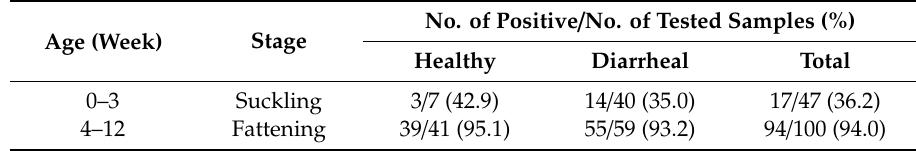
Table 2. Prevalence of porcine sapelovirus (PSV) infection of pigs in Zambia.